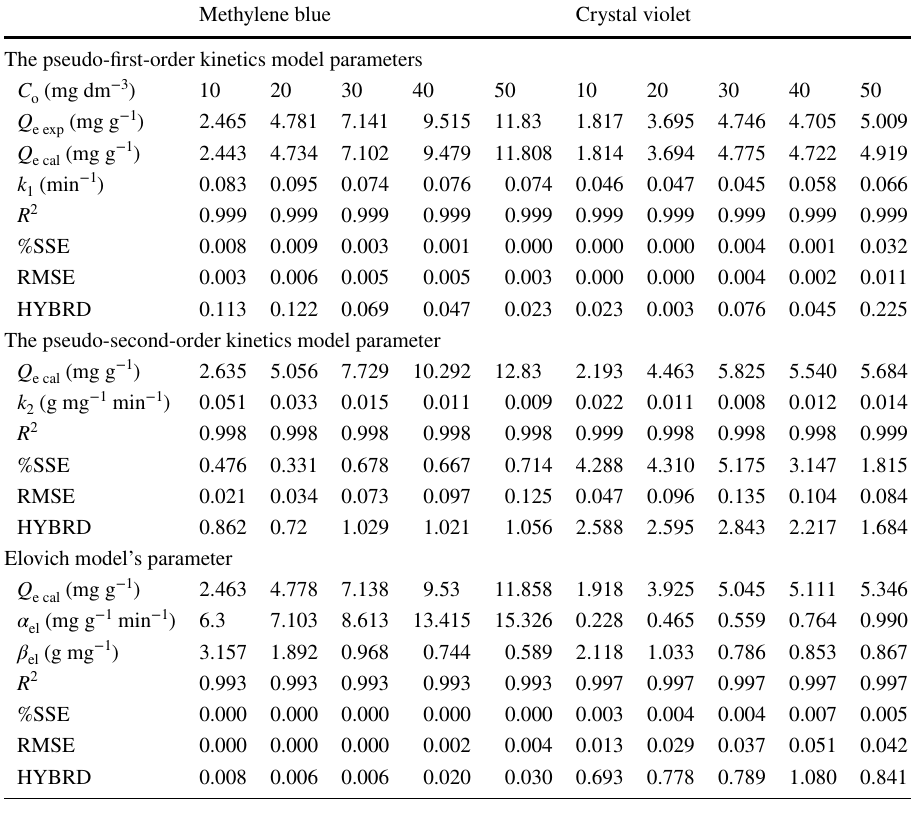
Table 5 Kinetic parameters for the adsorption of MB and CV onto MSH